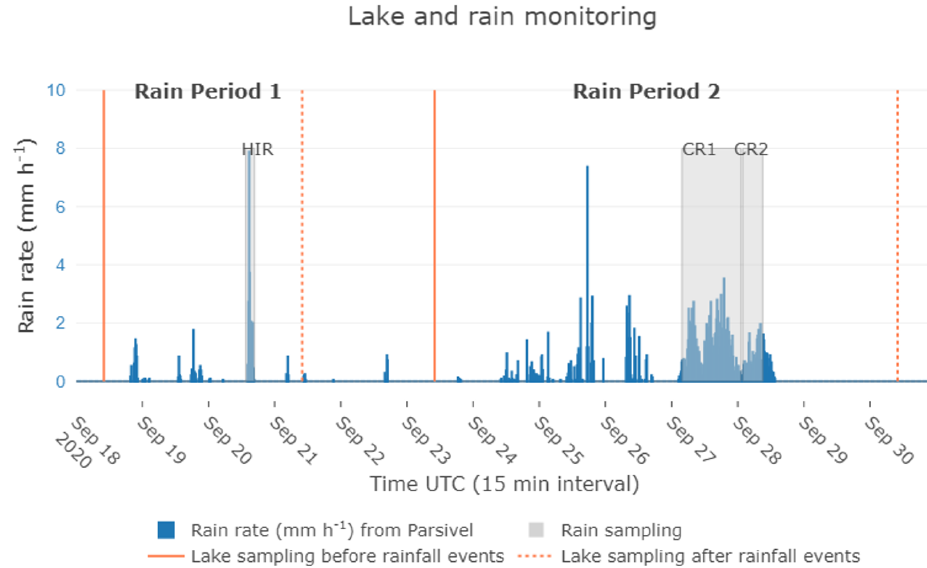
Figure 2. Rain rate intensity from the Parsivel 2 sensor measured at Aydat instrumental site, within a 15min interval. Lake samplings are indicated by orange lines, the continuous lines indicating sampling performed before rainfall events, and the dotted lines representing sampling performed after rain events. Grey areas indicate the rain sampling periods and their duration, recorded by the rain sensor. HIR (high-intensity short rain) belongs to rain period 1 and CR1/CR2 (continuous rain event 1/continuous rain event 2) belongs to rain period